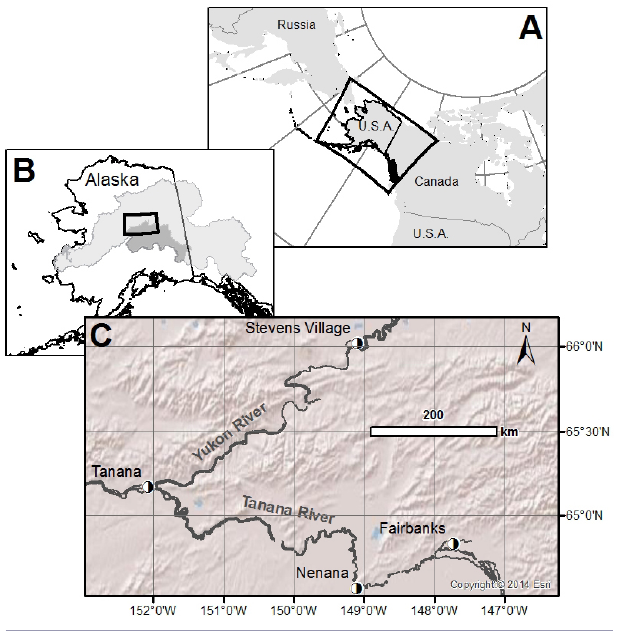
Fig. 1 . Study area map of Tanana, Alaska, and vicinity. (A) The regional location of Alaska relative to Canada, Russia, and the contiguous United States. (B) The Yukon and Tanana River watersheds within Alaska. (C) The locations of the communities of Fairbanks, Nenana, Tanana, and Stevens Village relative to the Yukon and Tanana Rivers.